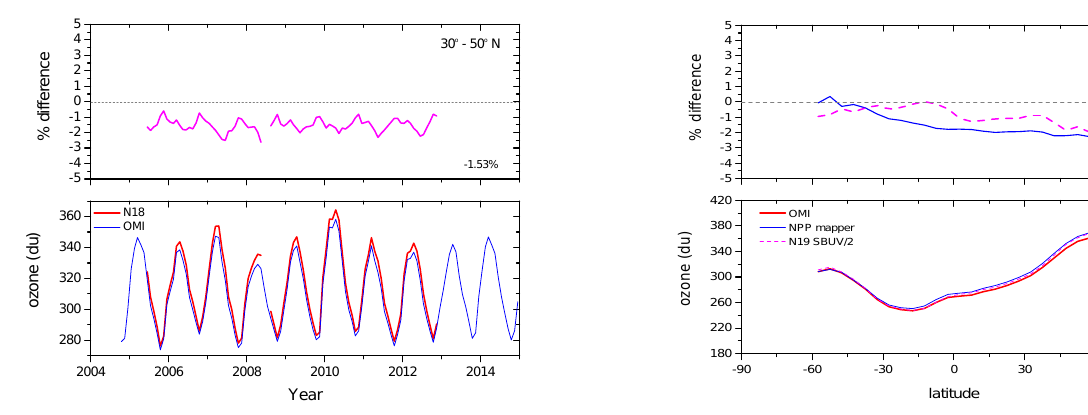
Figure 5. A similar time series albeit averaged from 30 to 50 ◦ N shows that ozone in the Northern Hemisphere was also stable rela- tive to N18 but had a somewhat higher bias.